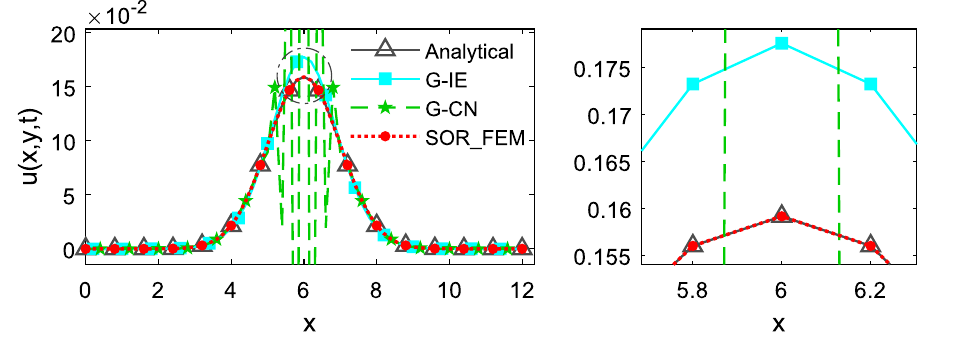
Figure 3. Temperature along the x-axis at time t =